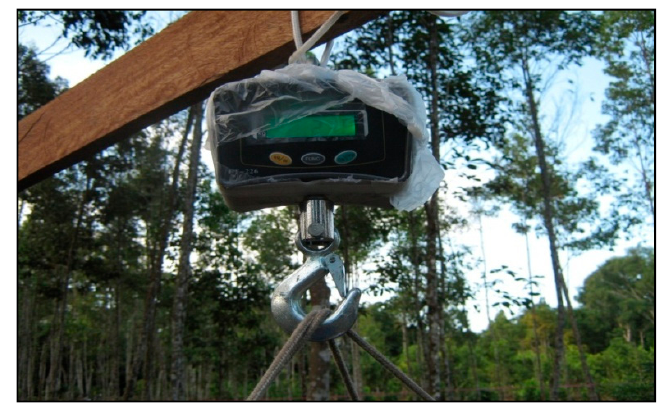
Figure A5. Digital scale for measuring the fresh massof the mass harvested in the rosewood plantations.